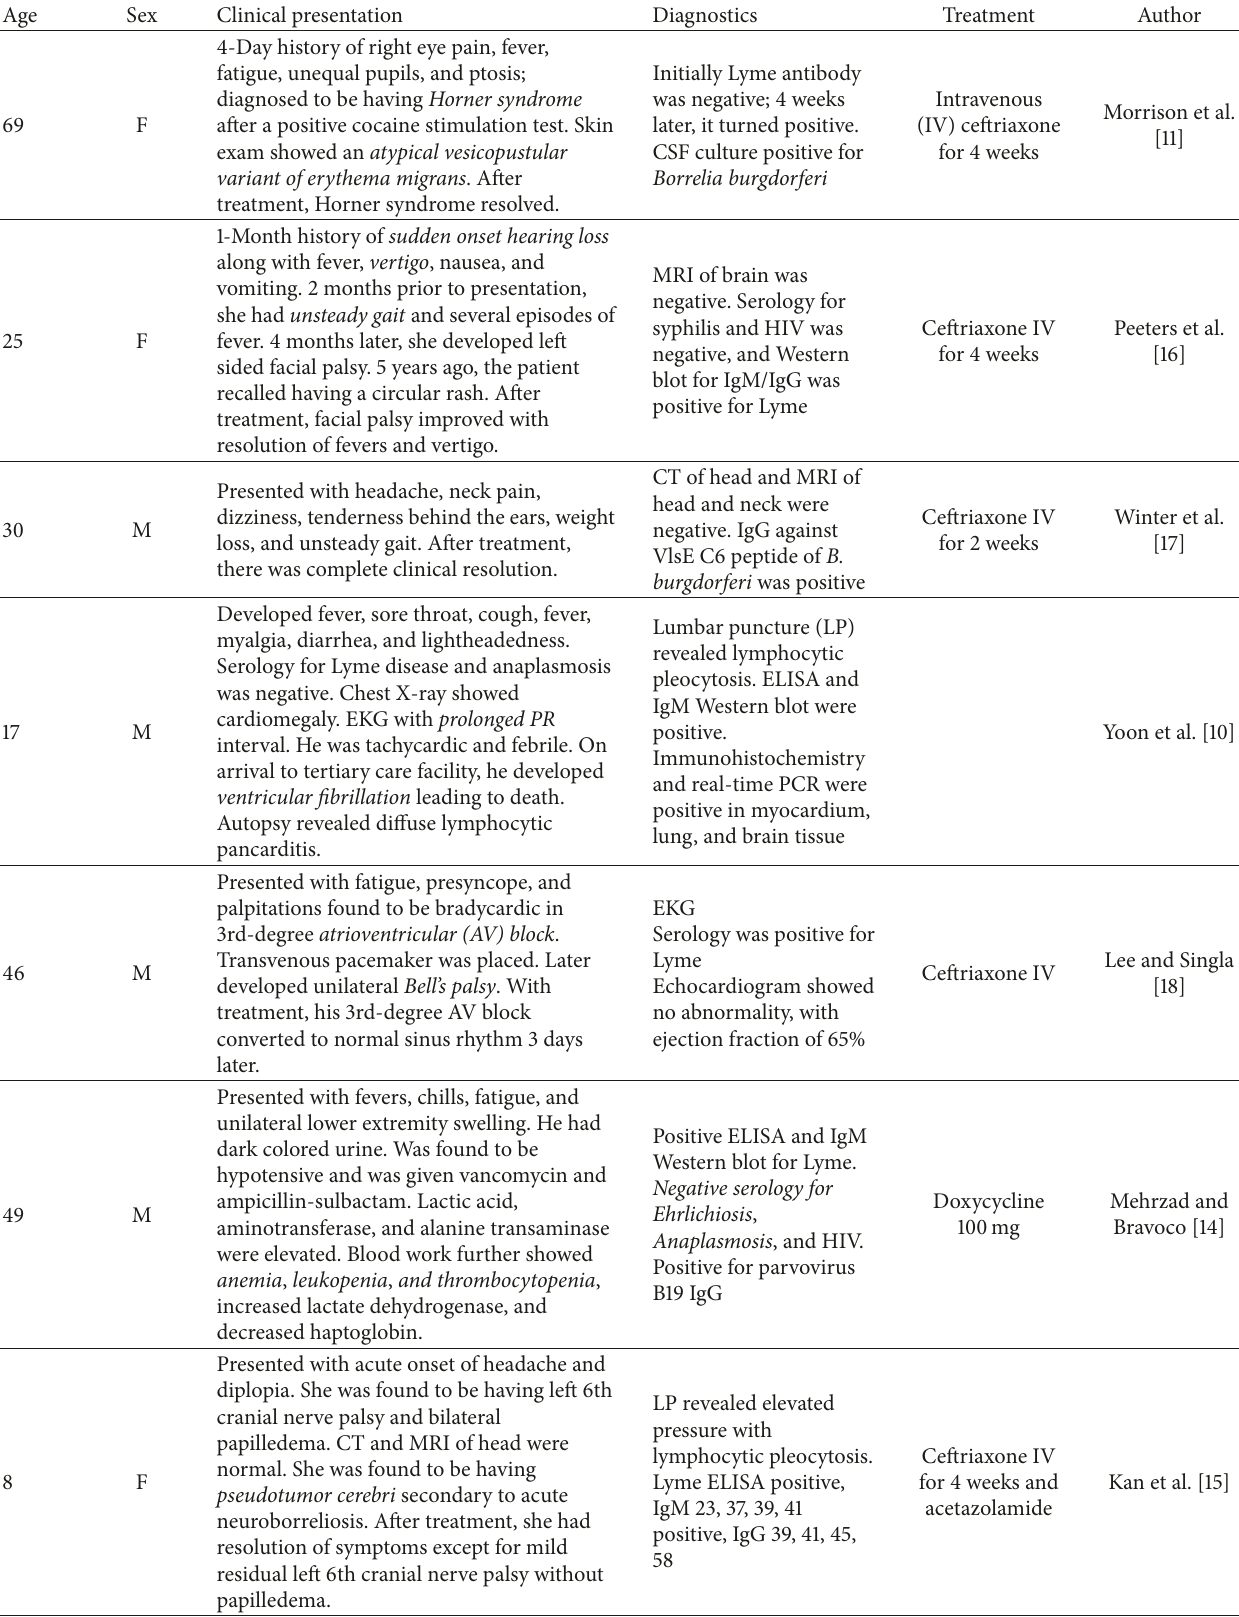
Table 1: Some of the atypical presentations of Lyme disease reported in the literature. Clinical presentation Diagnostics